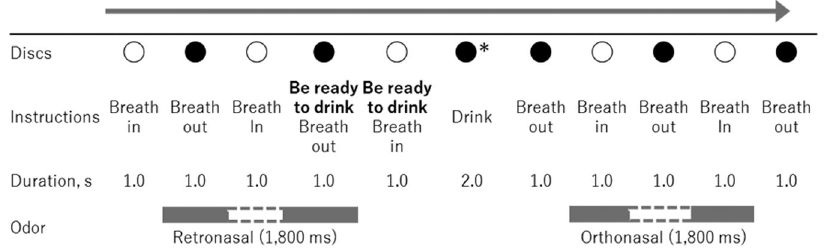
Figure 5. Time course of instruction and discs for the taste evaluation phase (Experiment 2). The odor stimulus was presented for a combined maximum of 1.8 s during two successive inhalations or two successive exhalations. The grey bars represent odor delivery; the white gaps represent a pause in odor delivery. * In the actual experiment, we displayed a red disc when participants were instructed to drink the solution.